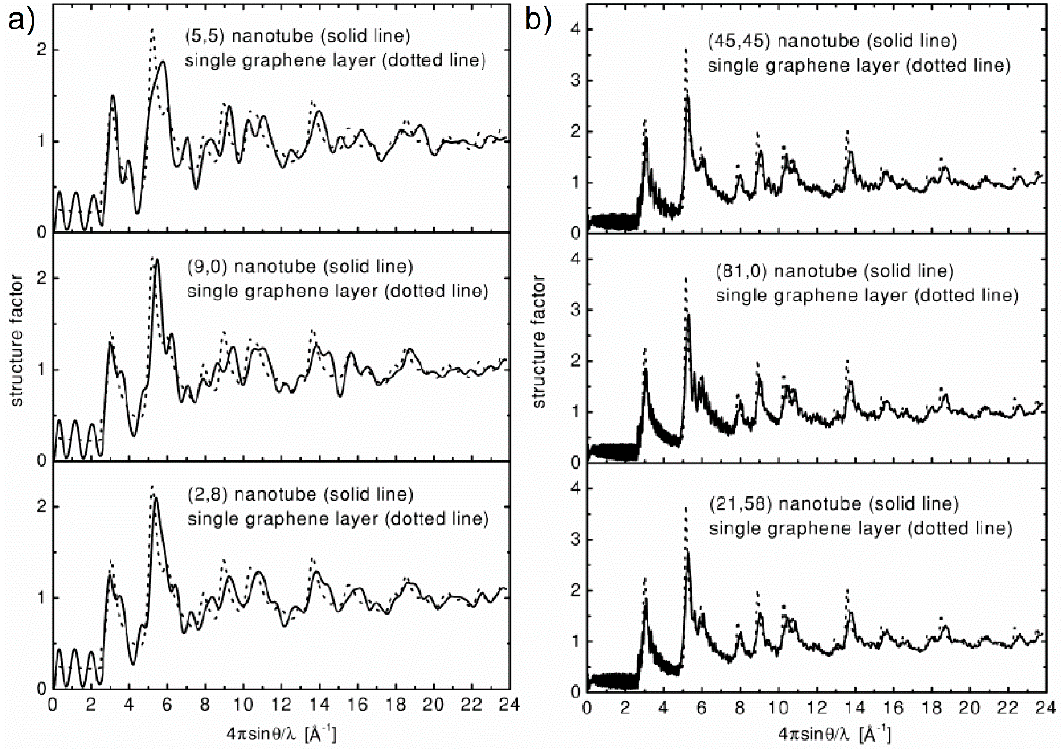
Figure 32. ( a ) Structure factors of (5,5), (9,0), (2,8), and ( b ) (45,45), (81,0), and (21,58) SWCNTs compared with that of a single graphene layer. Reproduced with permission from Koloczek et al. [109]. Copyright Elsevier,